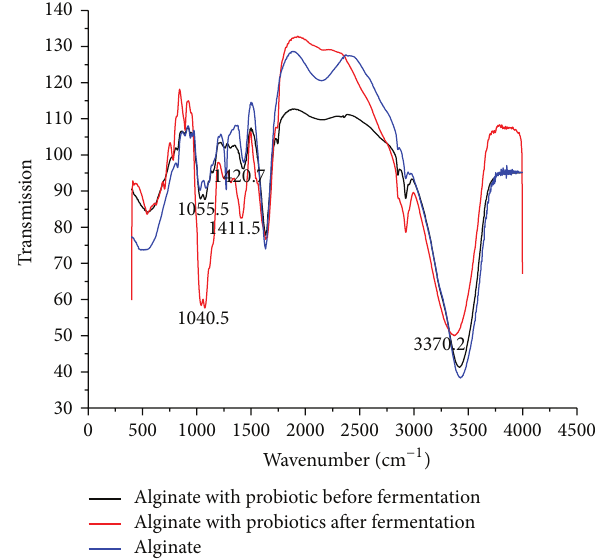
Figure 4: FTIR analysis of alginate beads with probiotics before and after